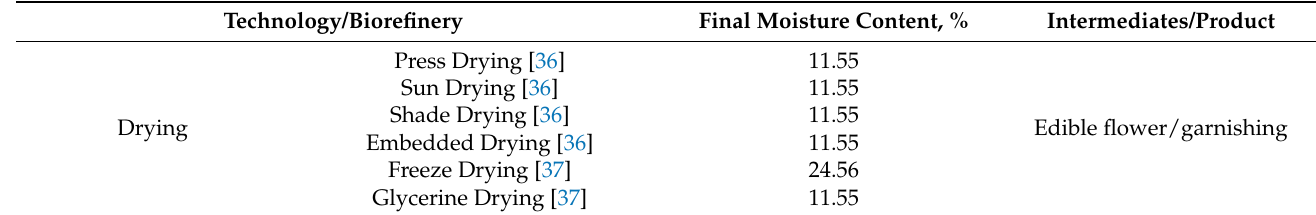
Table 5. Performance of drying processes.